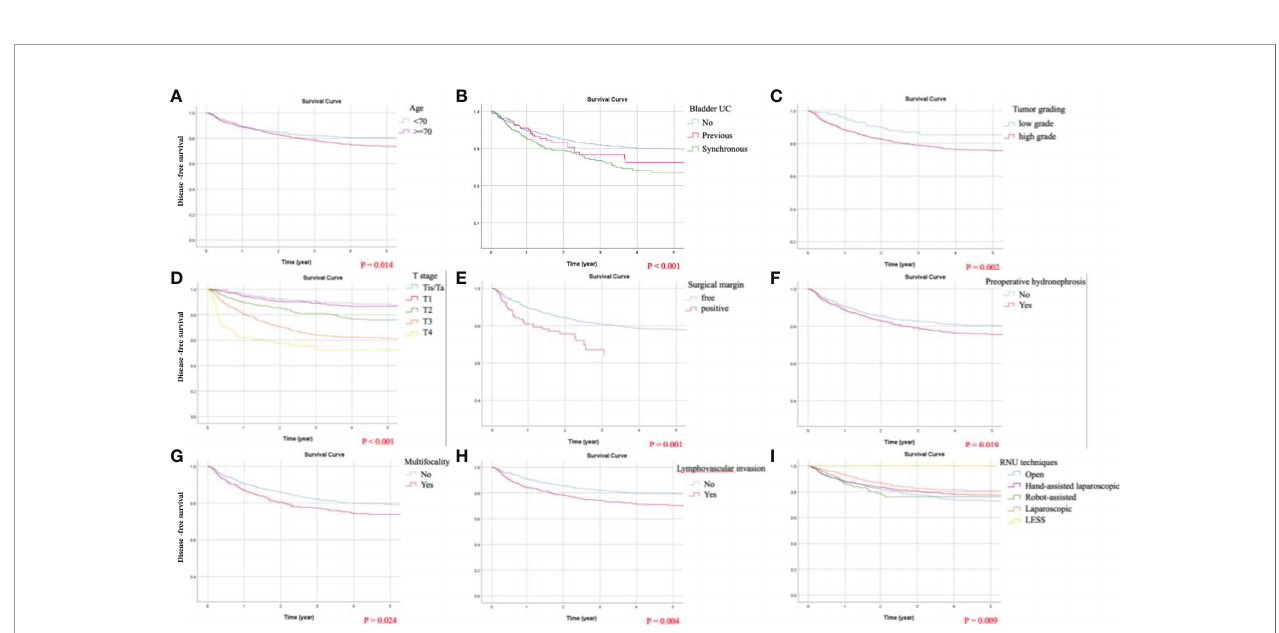
FIGURE 4 | Kaplan-Meier curves of disease-free survival (DFS) following adjustment for age, tumor size, preoperative hydronephrosis, distal ureteral or bladder cuff urothelial carcinoma (UC), multifocal UCs, previous or synchronous bladder UC, lymphovascular invasion (LVI), tumor necrosis, surgical margin, tumor grading, cell type, pathological T and N staging, and surgical approaches of radical nephroureterectomy (RNU). Signi fi cant predicting factors for DFS included: (A) age, (B) chronological history of bladder UC, (C) tumor grading, (D) T stage, (E) surgical margin, (F) preoperative hydronephrosis, (G) multifocality, (H) LVI, and (I) RNU